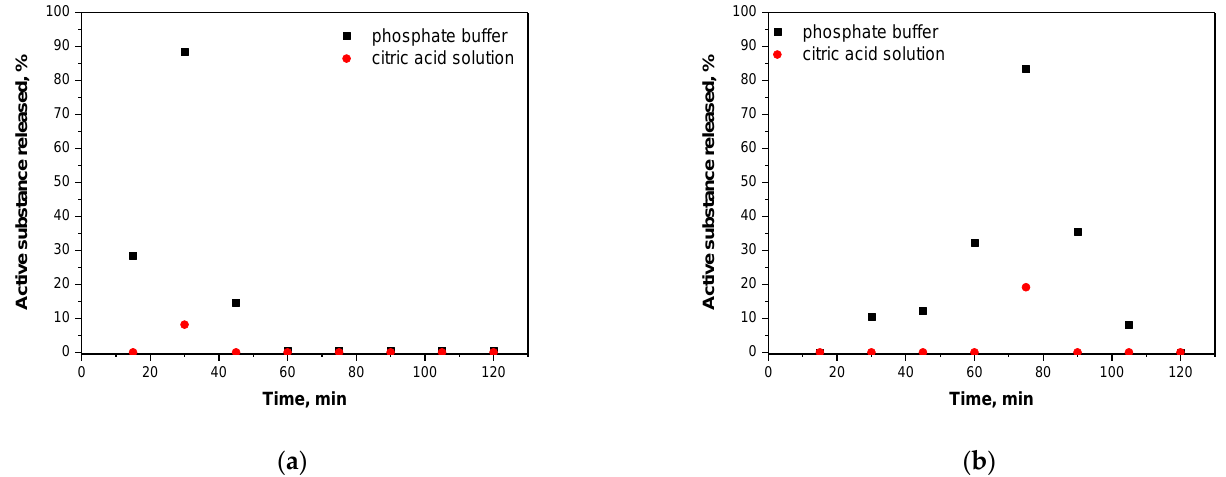
Figure 16. The percentage amount of the active substance released from alginate-based capsules ( a ) and chitosan/alginate-